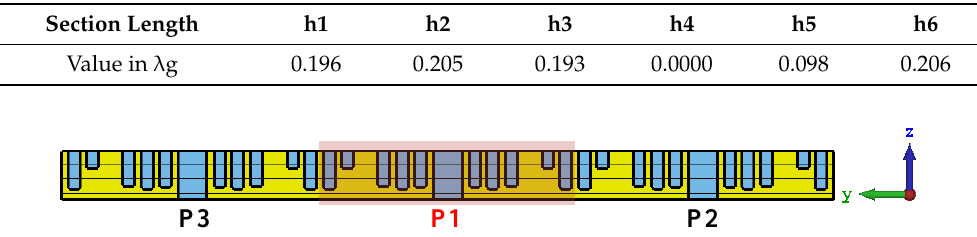
Figure 4. Cross-section of three sub-arrays along the sub-array main axis. The waveguides are shown in blue.